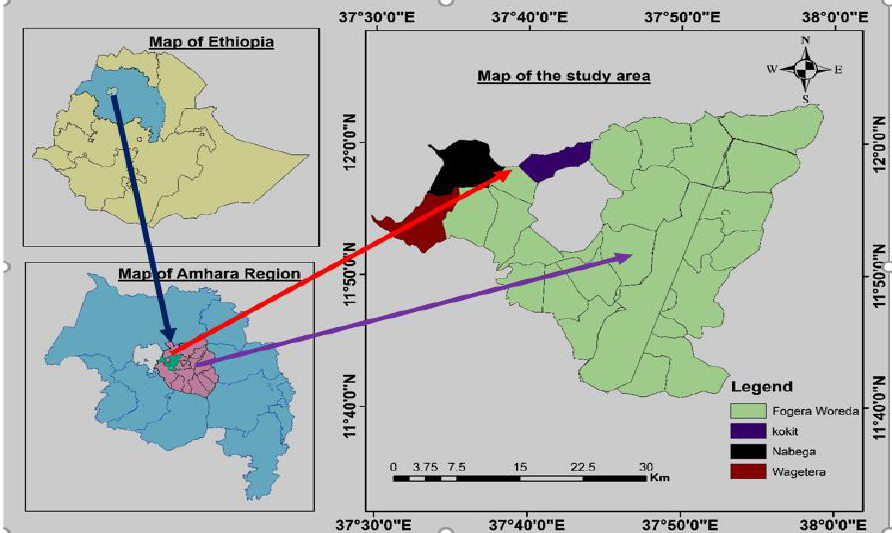
Figure 2. Location Map of the Study Area.